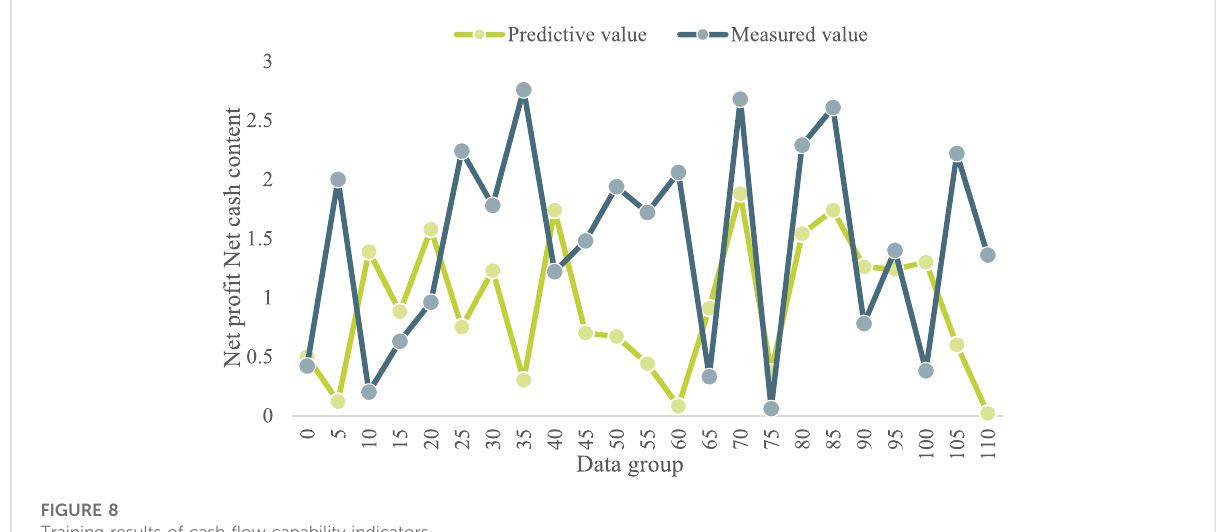
FIGURE 8 Training results of cash fl ow capability